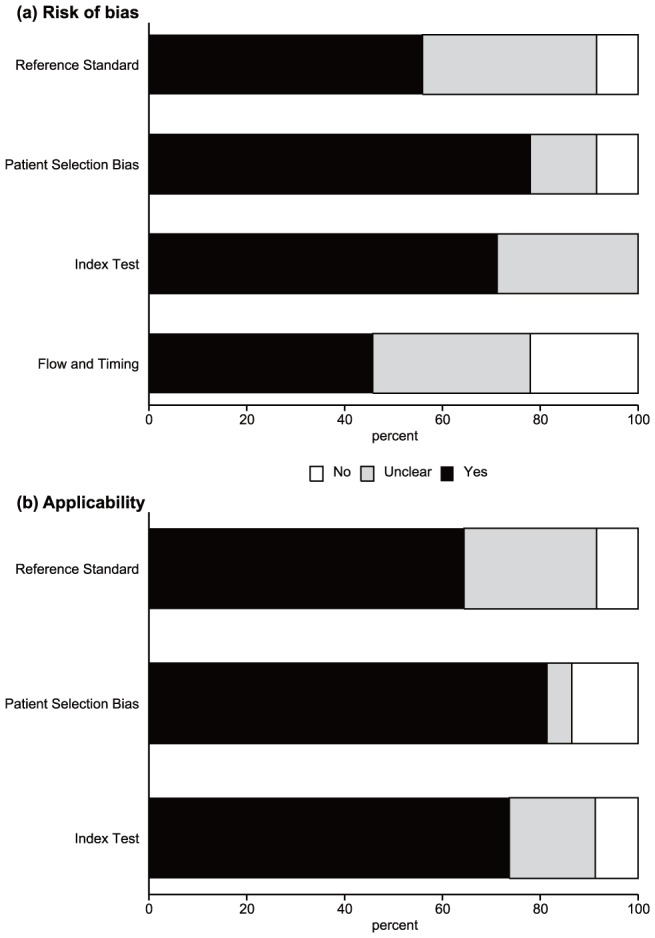
Overall quality assessment of included studies using the QUADAS-2 criteria (a: risk of bias; b: applicability).